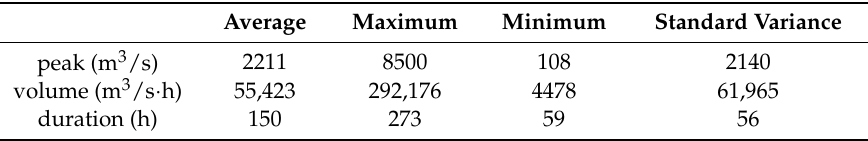
Table 1. Statistical indicators of historic flood